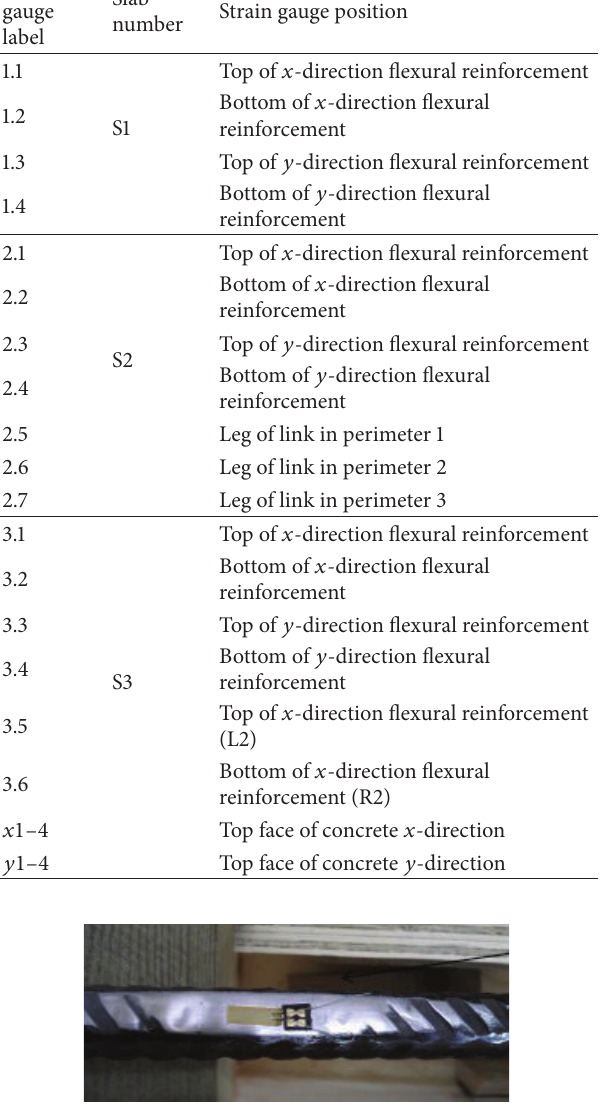
Figure 7: Strain gauge attached to an embedded steel bar.